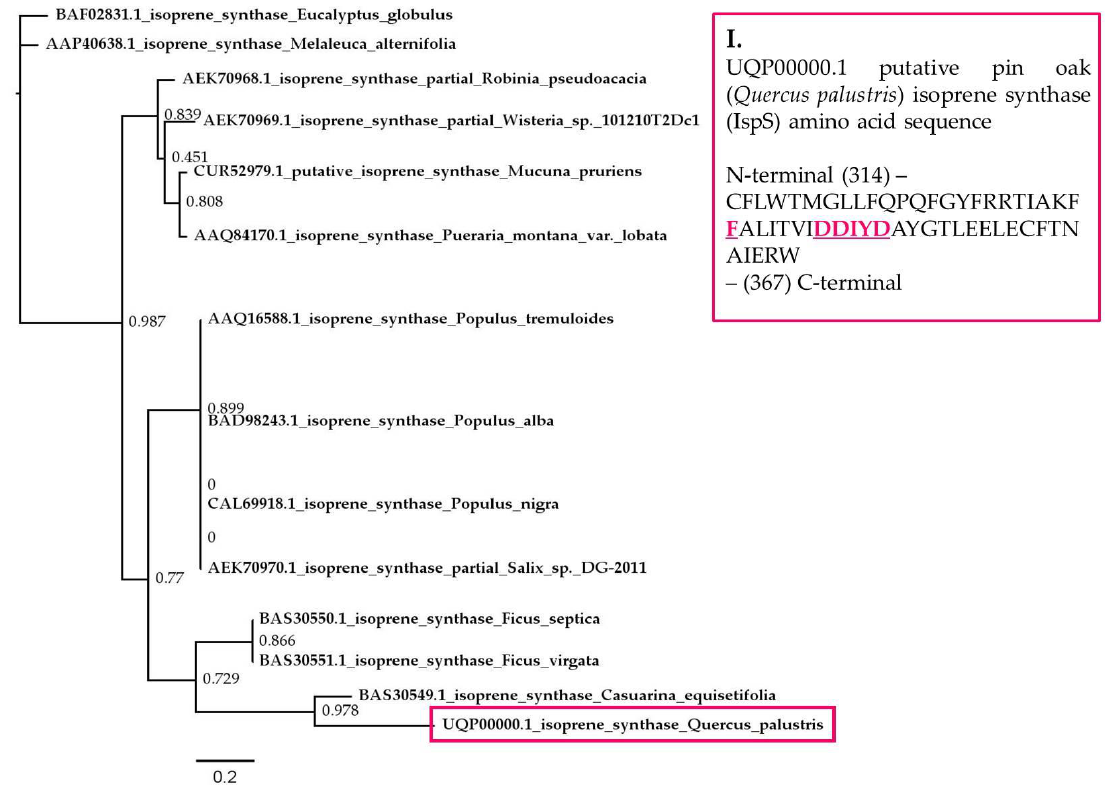
proteins (Figure S3b).